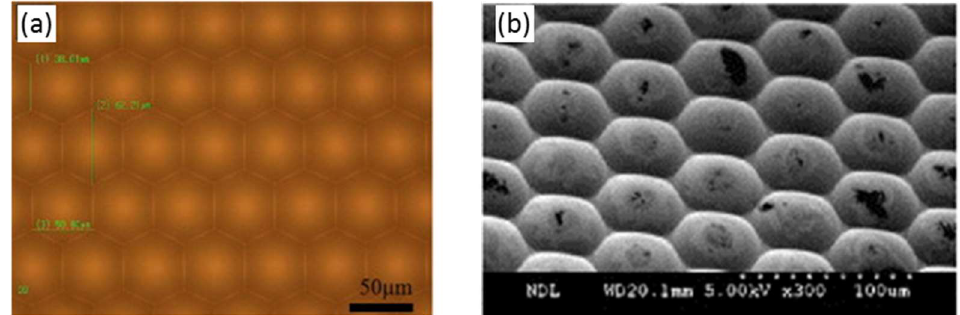
Figure 9. ( a ) Mold insert with a micro lens array fabricated using the Lithographie, Galvanik and Abformung (LIGA) process and ( b ) replicated micro lenses in a polymer film. Reproduced with permission from [123].